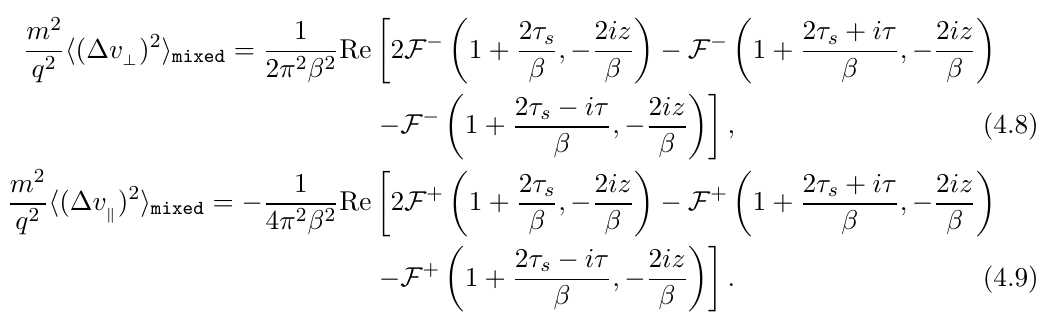
Figure 5 . Behaviour of the perpendicular component of the (cid:12)nite temperature dispersion as function of time (cid:28)=z for some values of switching time (cid:28) s =z . In this (cid:12)gure we choose (cid:12)=z = 0 : 5. where the polygamma